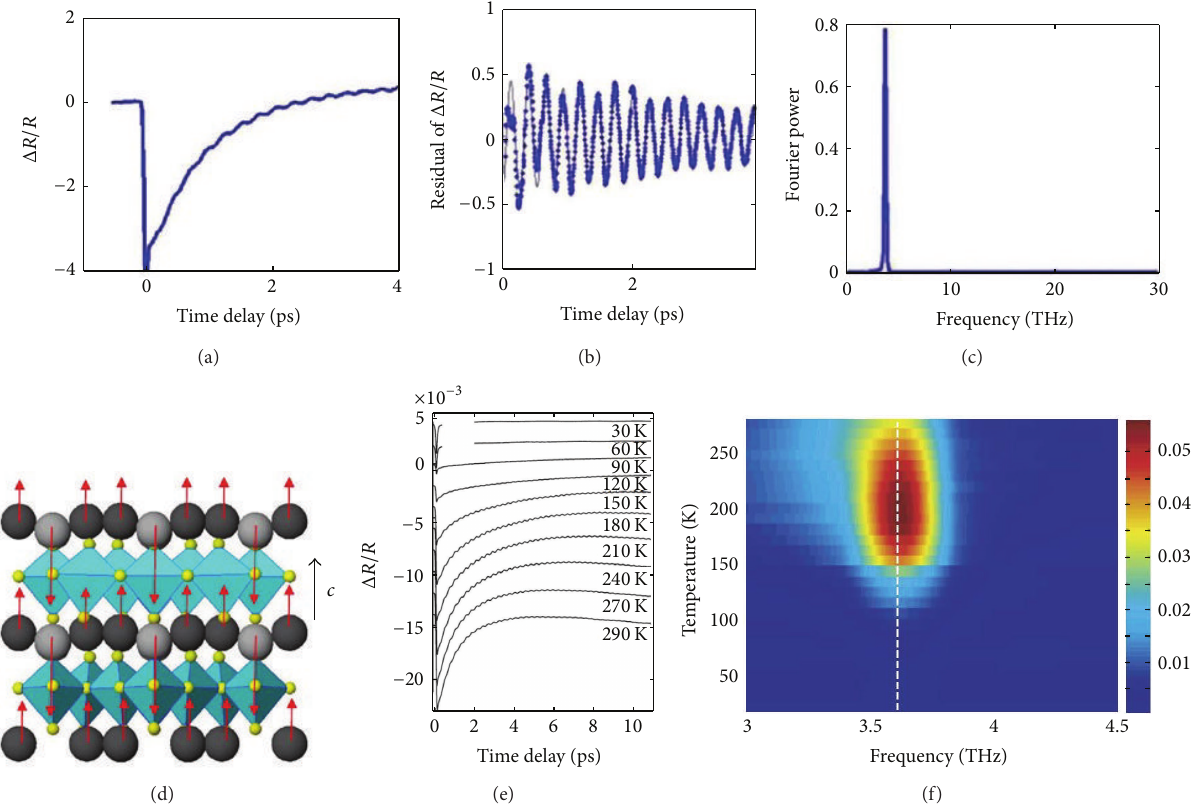
Figure 9: LuMnO 3 measured at 293 K. (a) Δ𝑅/𝑅 as a function of time delay. (b) Oscillation component after subtraction of the slowly varying response. (c) Fourier power spectrum of the data with frequency 3.61THz. (d) Schematic of the coherently excited A 1 phonon mode [36]. Reprinted figure with permission from Lou et al. [36]. Copyright (2009) by the American Physical Society. (e) Δ𝑅/𝑅 at various temperatures. (f) Fourier transformed amplitudes of coherent optical phonon [37]. Figures were reproduced with permission from Jang et al. [37].